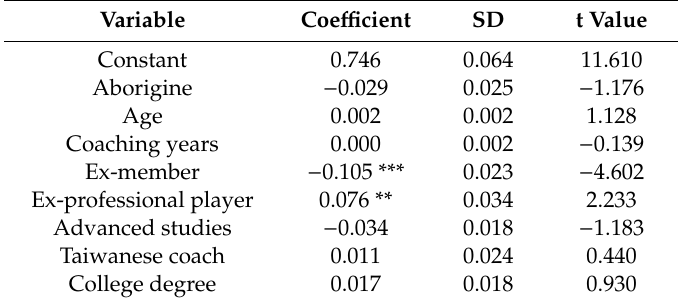
Table 7. Factors a ff ecting the integration performance of coaches of CPBL